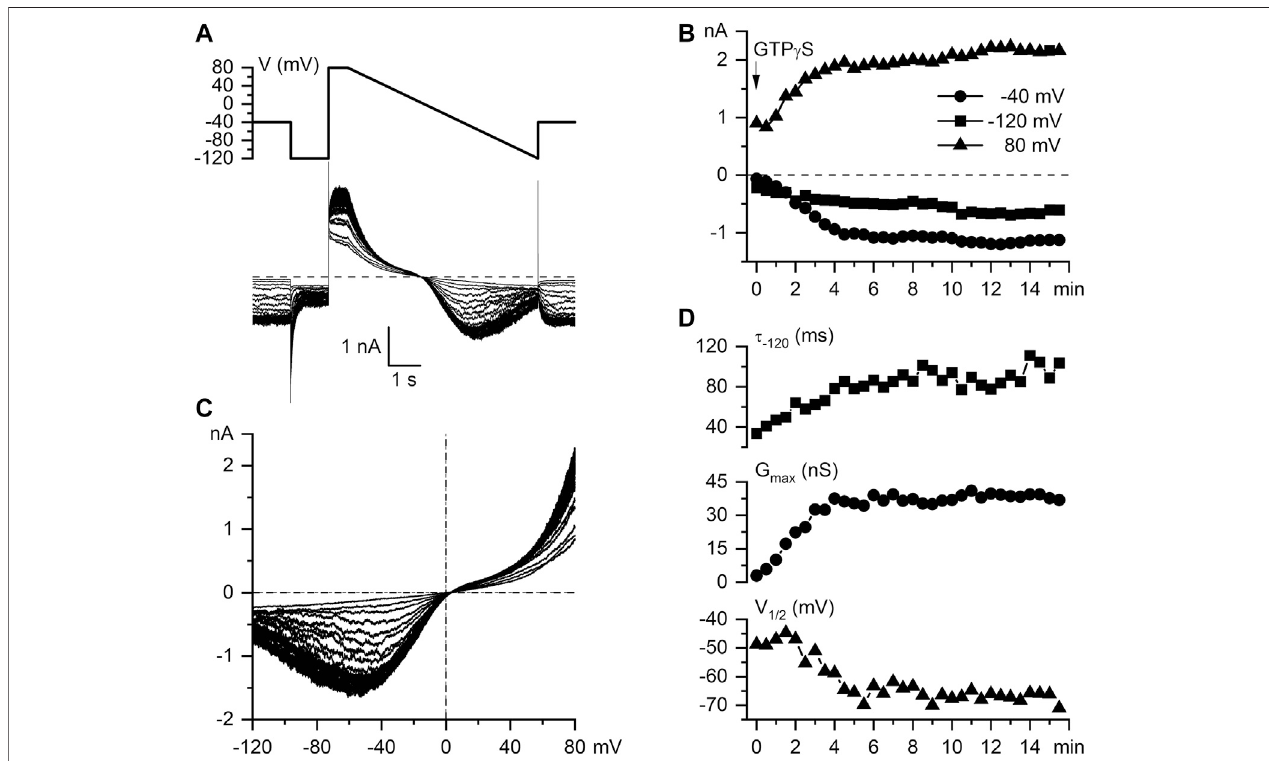
FIGURE 2 | Biophysical properties ofintracellular GTP γ S-induced mI CAT in mouse ileal myocytes. (A) Voltage protocol and superimposed current traces recorded in a mouse ileal myocyte at 30 s interval following break through with a patch pipette containing 200 µM GTP γ S. (B) Time course of current amplitudes measured at − 40 mV (holding potential), − 120 mV, and 80 mV, as indicated. (C) Superimposed mI – V curves measured by slow voltage ramps. (D) Top panel, time constant of CAT I GTP γ S-induced mI CAT deactivation during voltage step from -40 to -120 mV; middle and bottom panels, best- fi t parameters of the Boltzmann equation fi t of the cation conductance curves: the maximal conductance (G max ) and potential of its half-maximal activation (V 1/2 ),